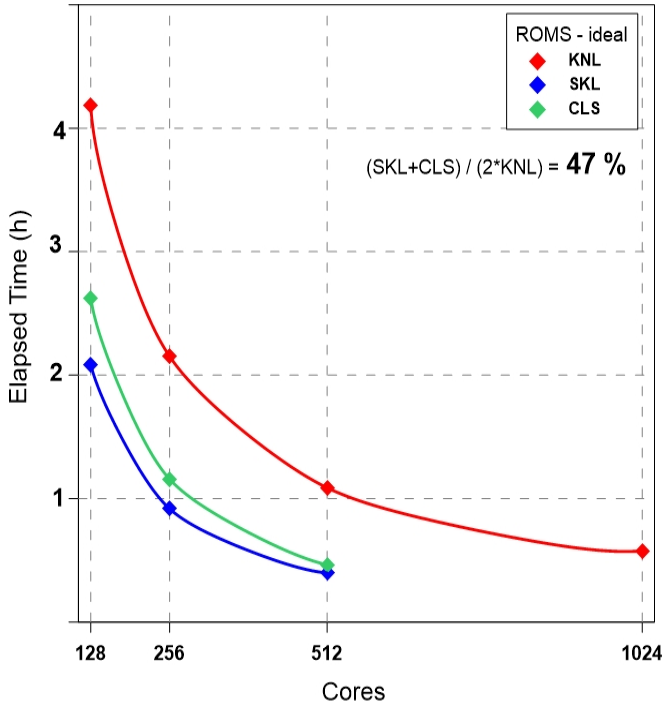
Figure 10. Performances of the benchmark experiment by the number of cores using ROMS: (SKL + CLS) / (2*KNL) = 47%.